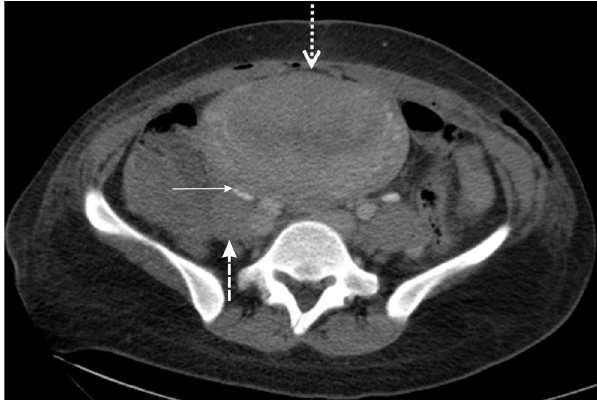
Figure 4 - Grade III-IV hydronephrosis (thick dashed arrow) and ureter obstruction (thin solid